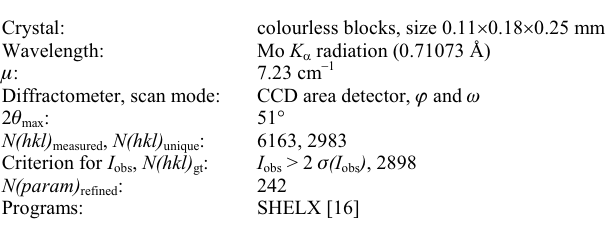
Table 1. Data collection and